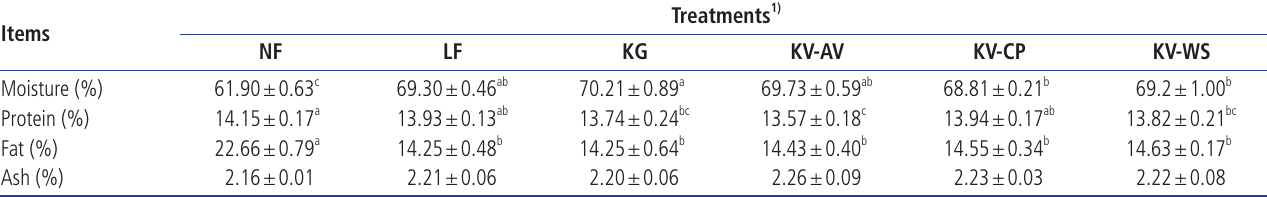
Table 3. The proximate composition of frankfurter sausages Items